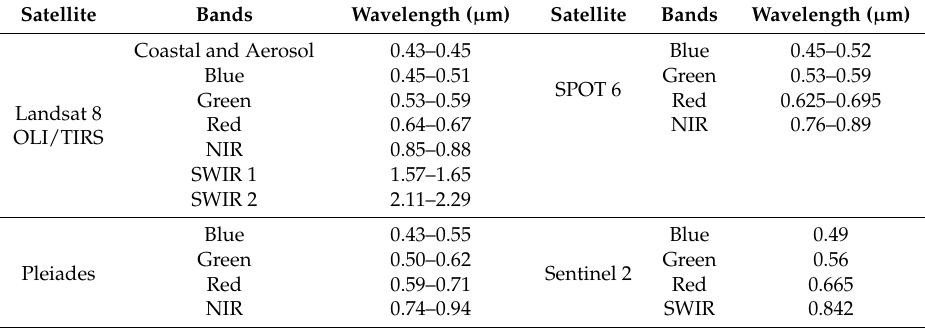
Table 2. The spectral band information of Landsat 8 OLI/TIRS used in image classifications, and Pleiades, SPOT 6 and Sentinel 2 used as reference